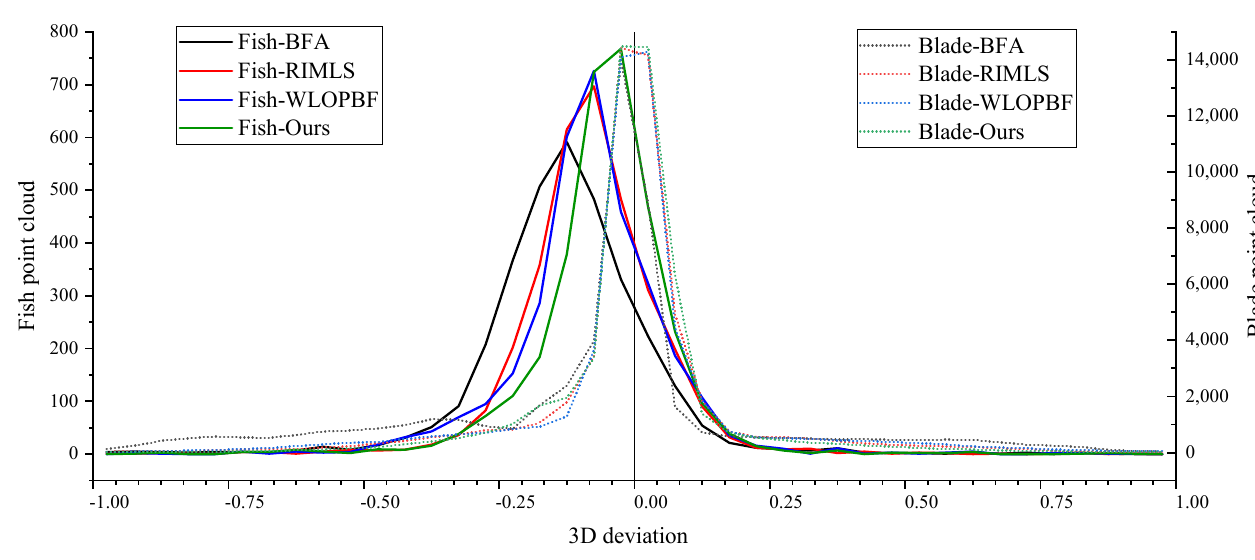
Figure 10. 3D deviation distribution chromatogram.